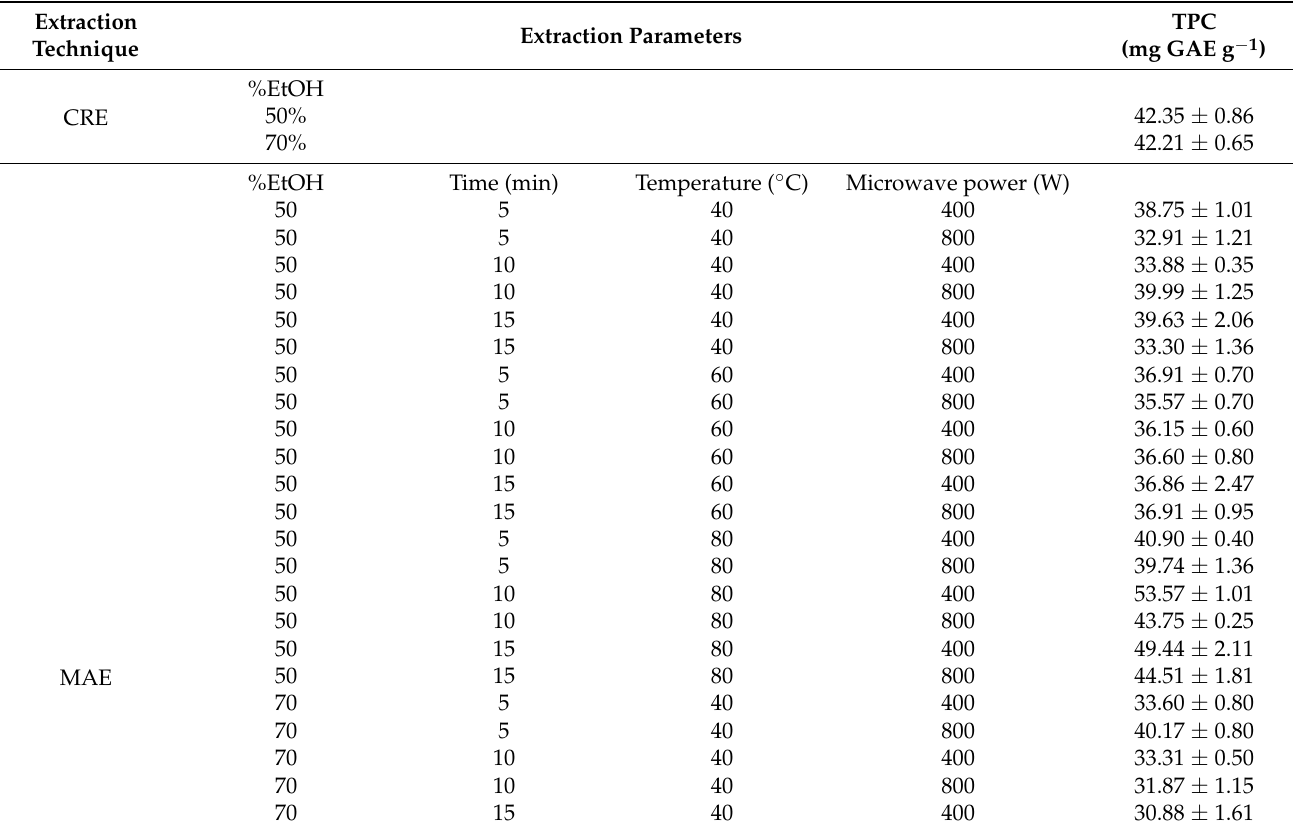
Table 1. Total phenolic content of L. nobilis L. leaf extracts obtained by different extraction parameters and techniques. Extraction